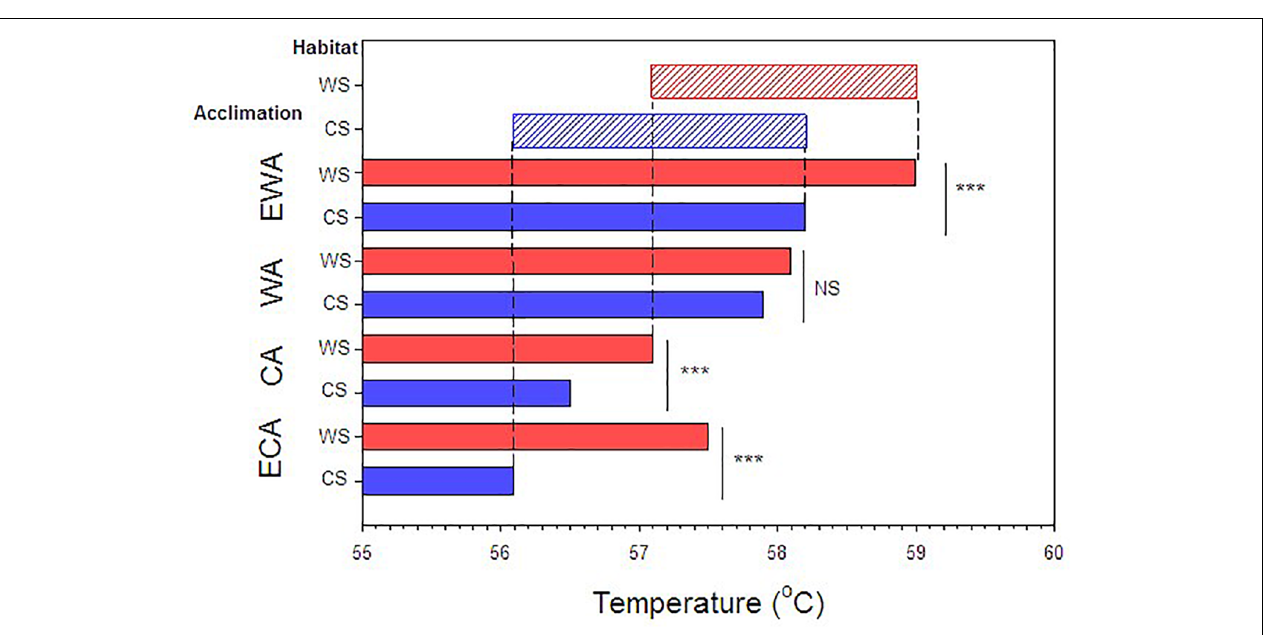
tolerance of this snail population to be 56.1 ◦ C ( p = 0.177; Table 2